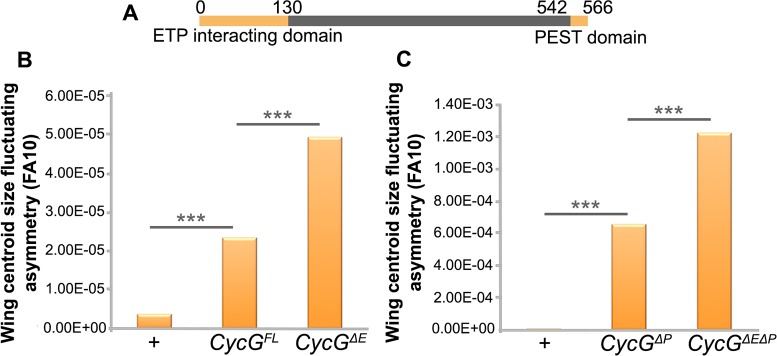
The ETP interacting domain limits CycG-induced
FA.A–Map of the 566 amino-acid Cyclin G protein showing the ETP
interacting and PEST domains. B–Wing centroid size FA
(FA10) of females da-Gal4/+ (+),
+/UAS-CycGFL;
da-Gal4/+,
(CycGFL) and
+/UAS-CycGΔE;
da-Gal4,
(CycGΔE).
C–Wing centroid size FA (FA10) of females
da-Gal4/+ (+), +/
UAS-CycGΔP;
da-Gal4/+
(CycGΔP) and
+/UAS-CycGΔEΔP;
da-Gal4/+
(CycGΔEΔP). (F-tests,
*** p-value<0.001, S3 Table). Source data are provided
in S4
Table.